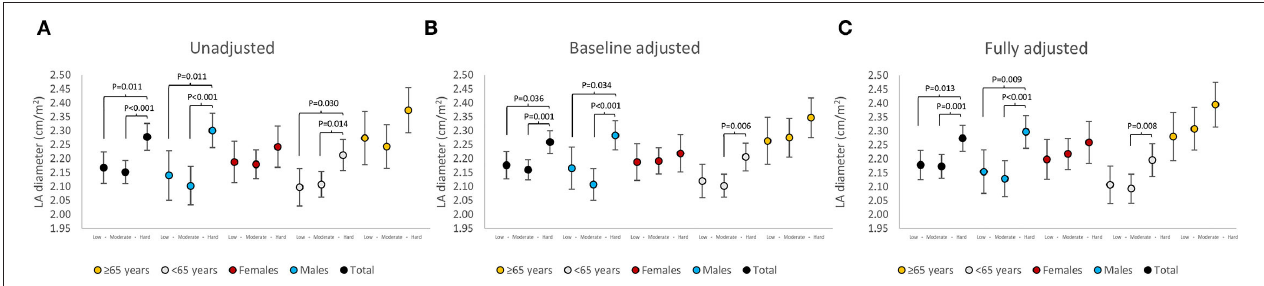
FIGURE 3 | Associations between cumulative PA and cross-sectional LA diameter index (LADi) in Tromsø7. (A) is unadjusted, (B) is adjusted for baseline LADi in Tromsø6, (C) is adjusted for baseline LADi in addition to age, sex, body mass index, and hypertension groups. Differences between groups of cumulative PA are indicated with p -values. Error bars indicate 95% CI. PA, physical activity; LA, left atrial; CI, confidence